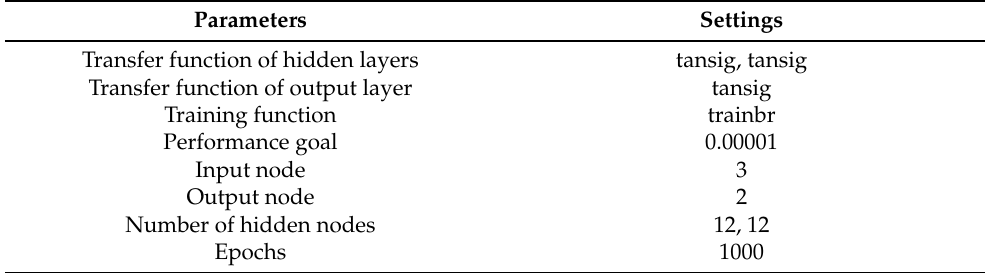
Figure 4. Experimental architecture of the proposed backpropagation ANN model. Table 2. Parameters of training